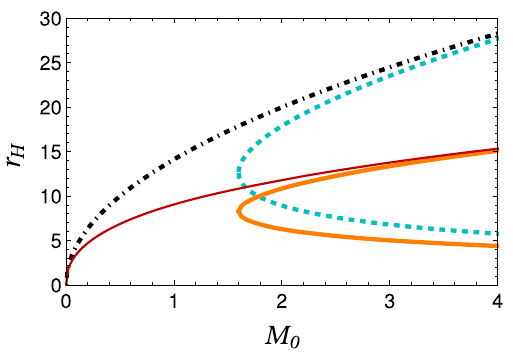
Fig. 3 Black hole horizons r H as a function of the mass M 0 for (cid:12) = 0 and J 0 = 0 (dotted dashed black line), (cid:12) = 0 and J 0 = 8 (blue dashed line), (cid:12) = 0 . 1 and J 0 = 0 (solid thin red line) and (cid:12) = 0 . 1 and J 0 = 8 (solid thick orange line). In addition (cid:8) 0 = 5 and the values of the rest of the parameters have been taken as